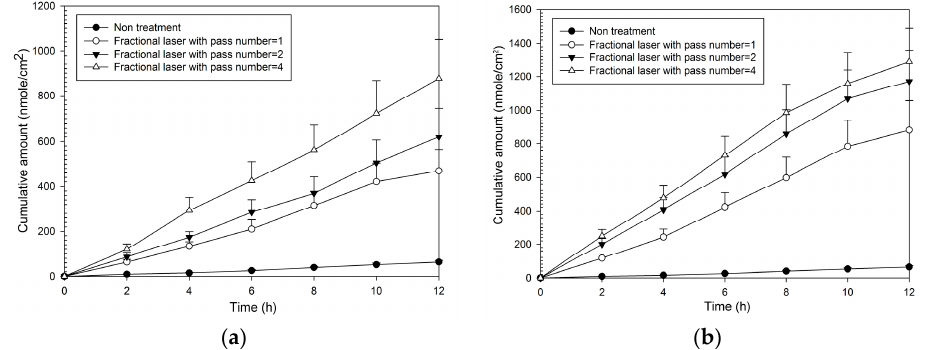
Figure 3. Cumulative amount of time profiles of in vitro transdermal permeation through porcine skin of MAP-1, after fractional CO 2 laser pre-treatment with a 12 mm spot size and different pass numbers at ( a ) 5 W and ( b ) 9 W fluence.